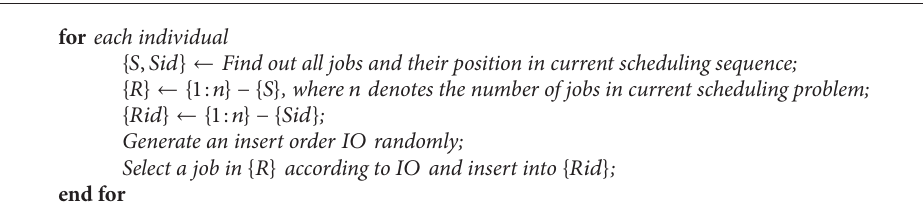
Algorithm 5: The pseudocode of